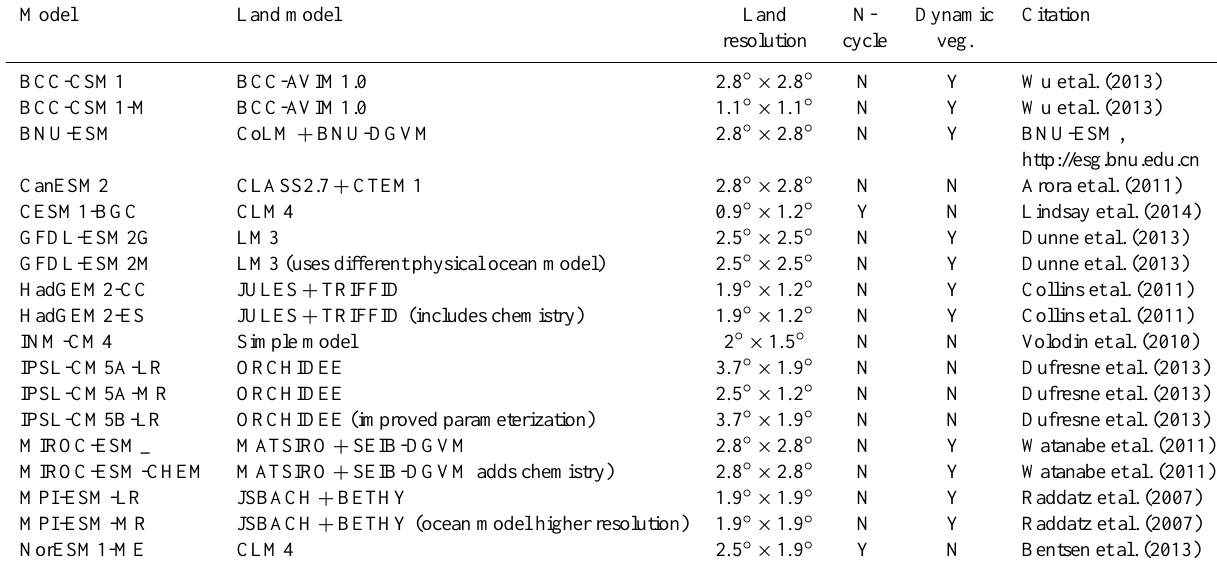
Table 1. Model simulations from the Climate Modeling Intercomparison Projection (CMIP5) included in this study. All models listed here were available for the RCP8.5 analysis, while all models except BNU-ESM and CESM-BGC were available for the RCP4.5